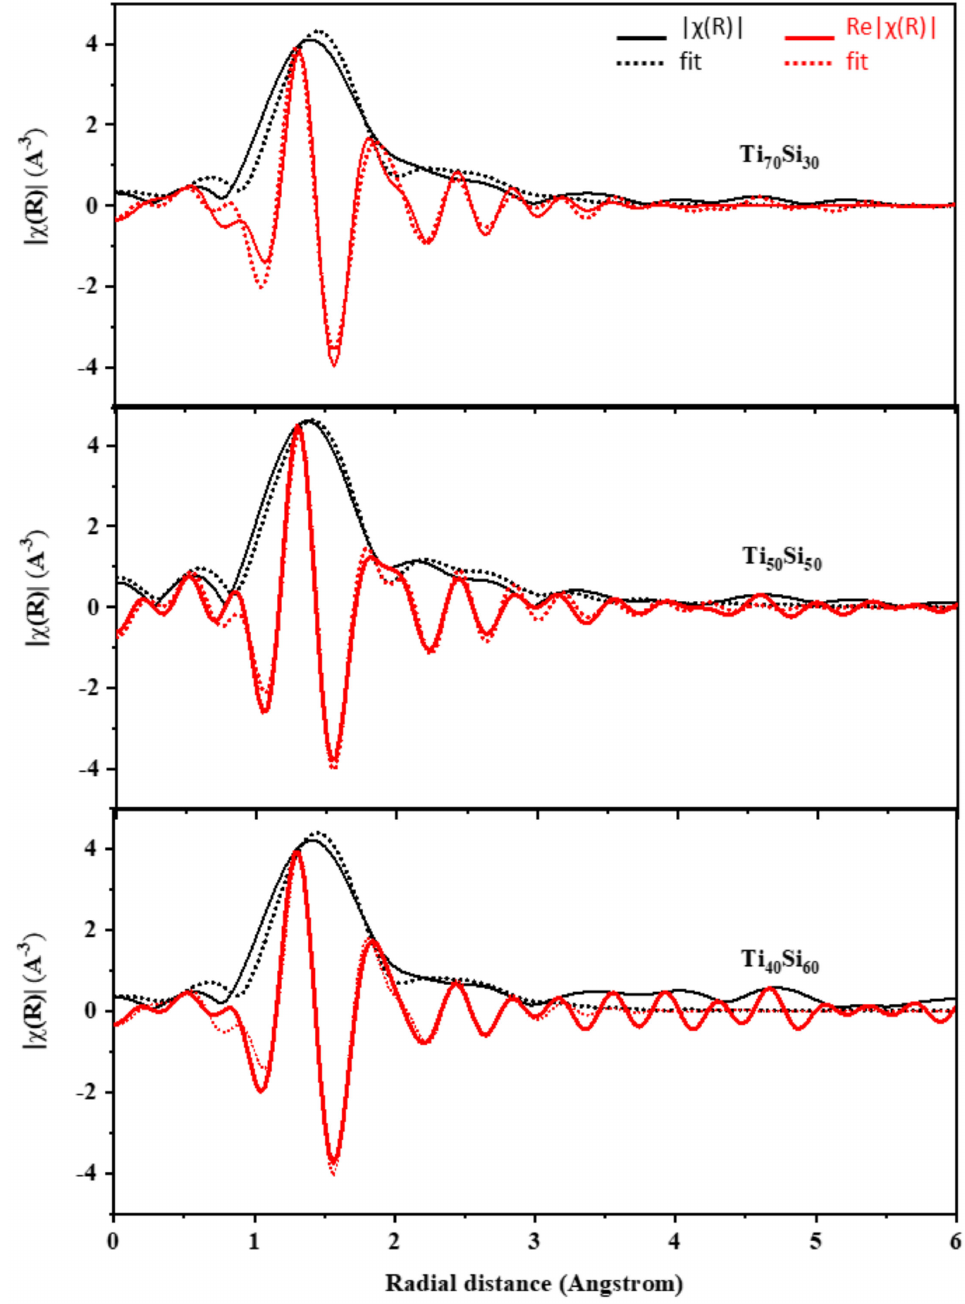
Figure 18. The experimental EXAFS data of Ti x Si y oxide synthesized at pH 9.0 with different Ti/Si ratios in R-space within the intermission of 1.1–3